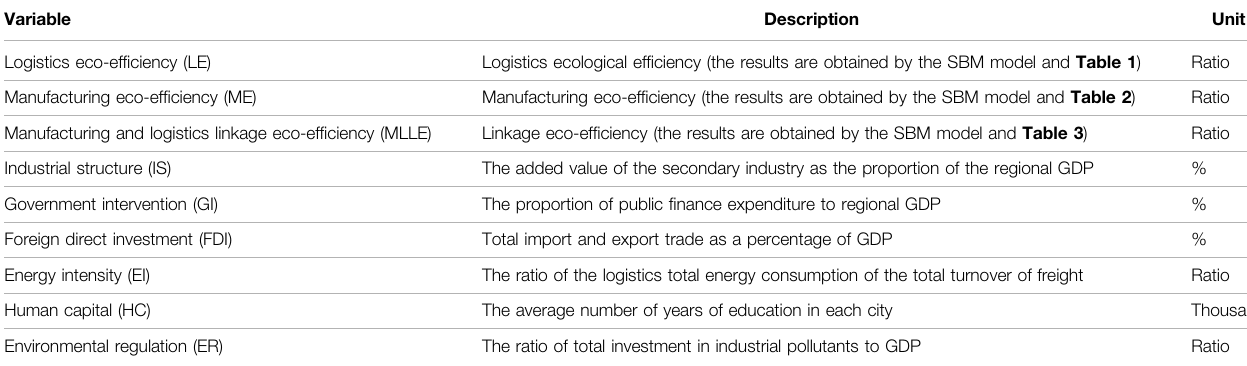
TABLE 4 | Variable description for spatial econometric